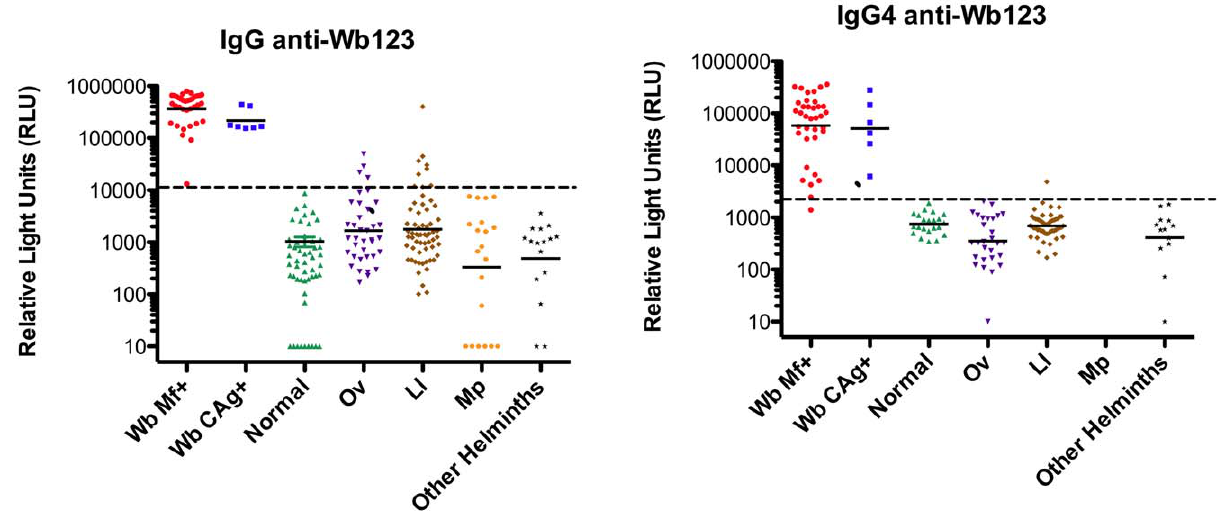
Figure 3. Wb123-specific IgG and IgG4 in W.bancrofti and related helminth infections. IgG and IgG4 antibodies to Wb123 distinguish Wuchereria bancrofti -infected subjects from those with related filarial and non-filarial helminth infection. IgG (Left panel) or IgG4 (Right panel) antibodies to Wb123 in individual serum samples from those with Wuchereria bancrofti (Wb), Onchocerca volvulus (Ov), Loa loa (Ll), Mansonella perstans (Mp), other helminth infections, or no infection (Normal). Each dot represents an individual sample and the horizontal line is the geometric mean (GM). The dashed line represents the cutoff between negative and positive based on ROC analysis.